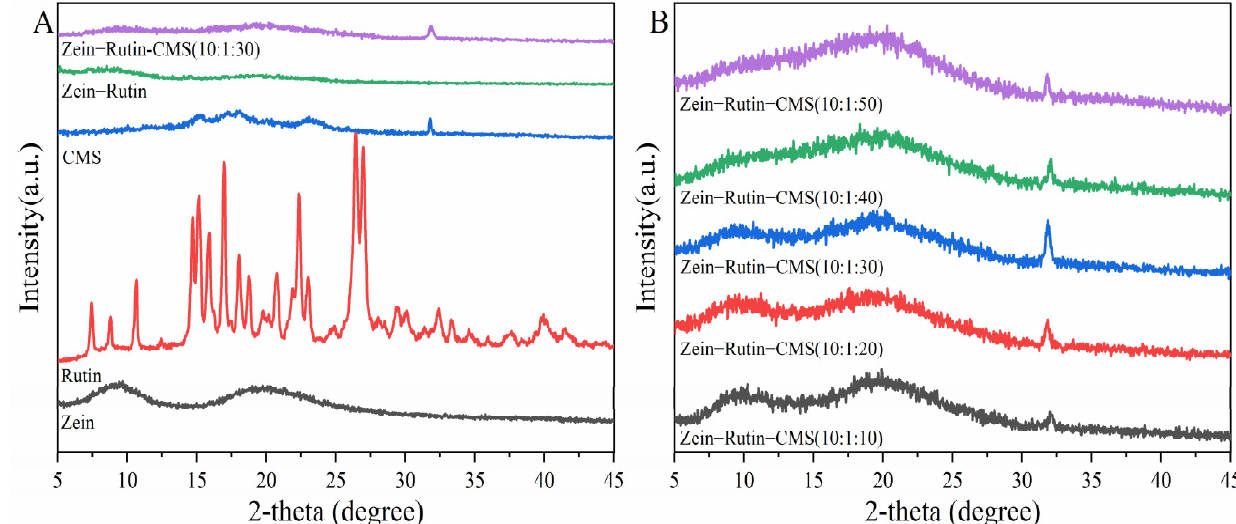
Figure 4. XRD: ( A ) Comparison of XRD among zein, CMS, RT, zein–RT, and zein–RT–CMS nanoparticles; ( B ) XRD of zein–RT–CMS nanoparticles at different levels of CMS.